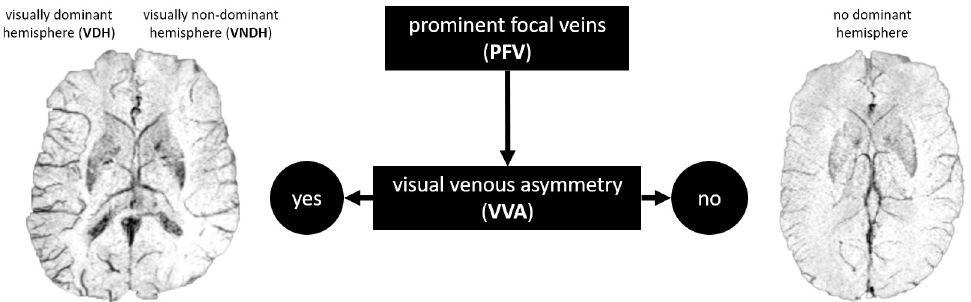
Fig 1. Image analysis procedure by readers. SWI MinIP of two separate patients with acute migraine with aura. Left: visual venous asymmetry (VVA) with radiological right-sided visually dominant hemisphere (VDH). Right: no VVA and no